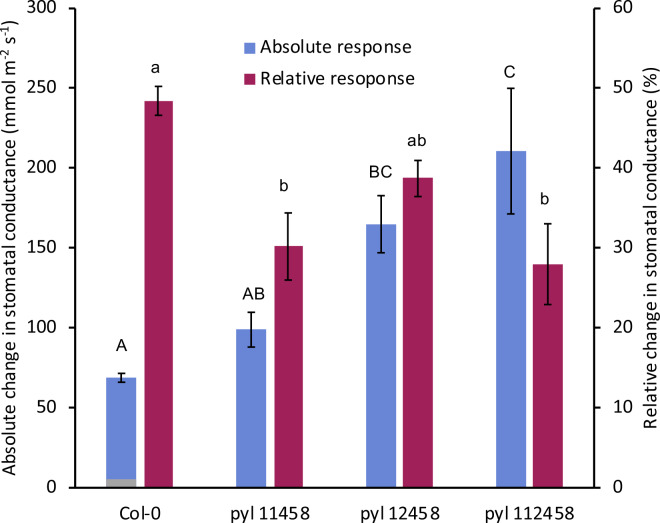
PYR/RCAR ABA receptor pyr1 pyl2/4/5/8 quintuple mutant (pyl-12458) and pyr1 pyl1/2/4/5/8 (pyl-112458) sextuple mutant show larger absolute stomatal closing responses during the first 20 min under elevated CO2 compared to wild-type (Col-0) (light blue bars).Changes in stomatal conductance (gs) after the first 20 min CO2 elevation (gs20) in absolute units (left Y axis scale mmol m−2 s−1) and relative units (right Y axis scale in %: (gs0-gs20)/gs0). gs0 = steady state stomatal conductances prior to CO2 elevation. In absolute units, pyrpyl sextuple mutant stomata close the most (light blue bars: pyl-112458). In contrast, in normalized units, the pyrpyl sextuple appears to close stomata the least compared to wild-type (dark purple bars), high-lighting pitfalls of gs normalization. Capital letters show differences in absolute responses (p=0.000158), whereas lower case letters in relative responses (p=0.00158; ANOVA, generalized linear model and Tukey post-hoc).Figure 9—figure supplement 1—source data 1.Absolute and relative changes in stomatal conductance values used in Figure 9—figure supplement 1.